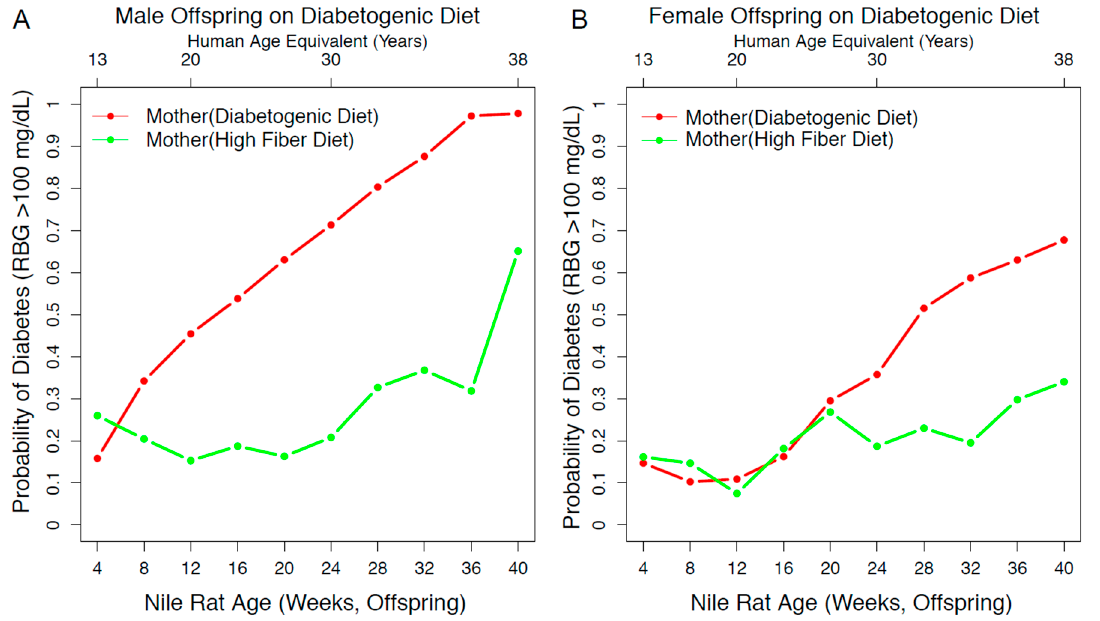
Figure 5. The probability of diabetes due to maternal diet was reduced to a larger extent in the male offspring. ( A ) In male offspring on a diabetogenic diet, the ones from mothers on a high-fiber diet experienced a reduced probability of diabetes from 8 to 40 weeks old. The number of Nile rats: n = 62 (green), n = 183 (red). ( B ) In female offspring on a diabetogenic diet, the ones from mothers on a high-fiber diet experienced a reduced probability from 25 to 40 weeks old. The number of Nile rats: n = 33 (green), n = 172 (red).